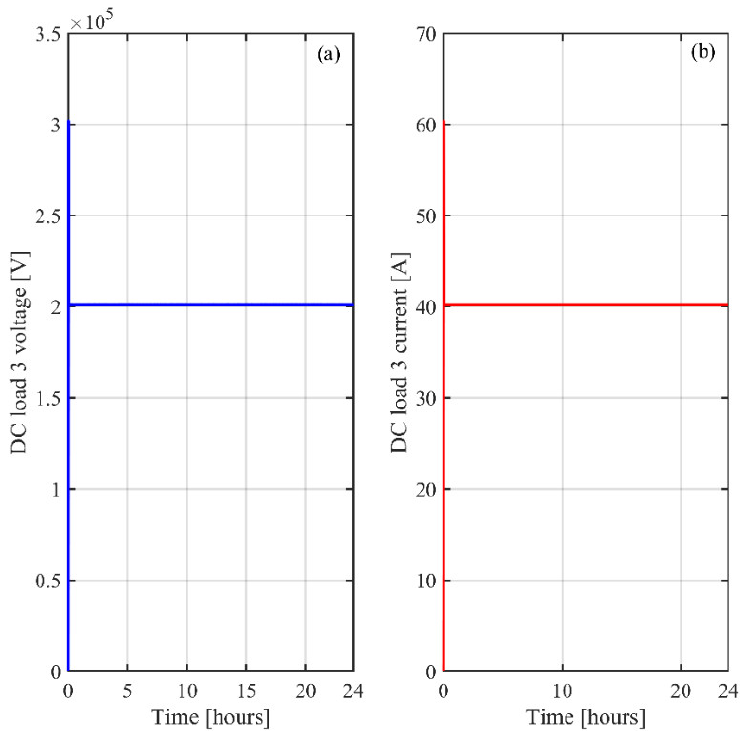
Figure 17. Voltage ( a ) and current ( b ) of the HVDC distribution at DC load 3.